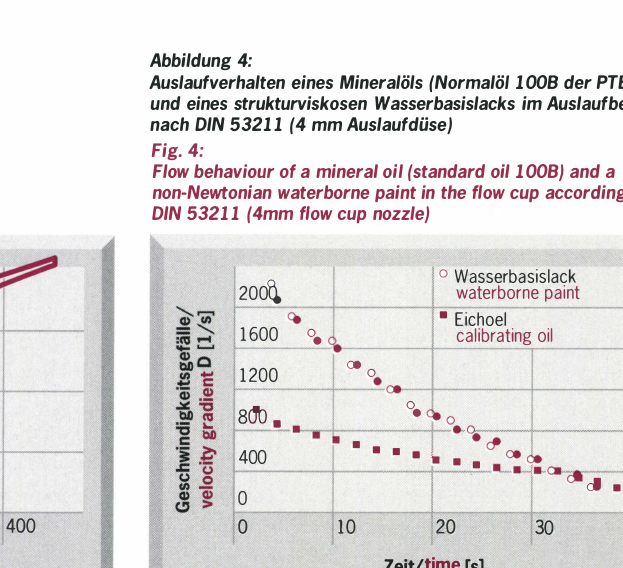
0 Wasserbasislack waterborne paint